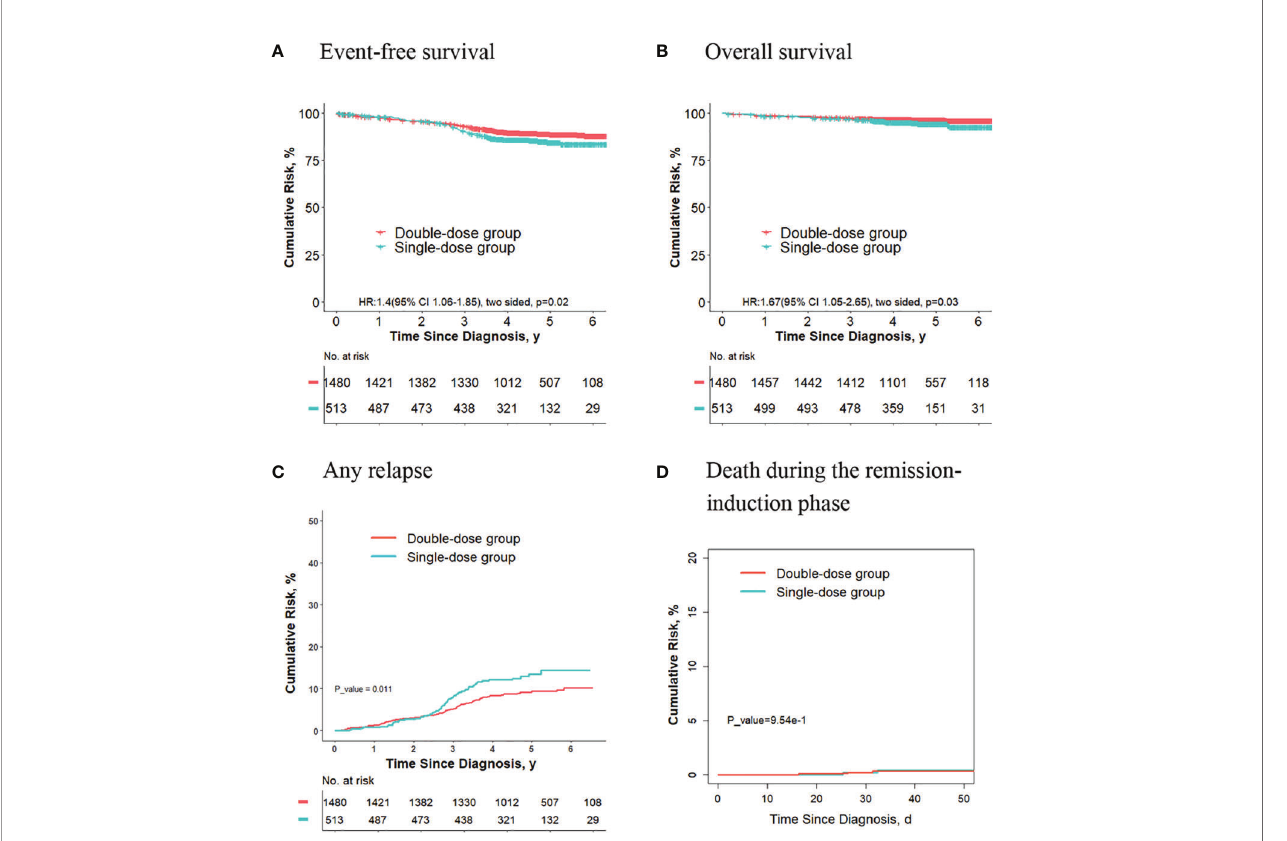
FIGURE 2 | Analysis of survival and cumulative risk of relapse and early death for patients with ALL in the fi nal low-risk